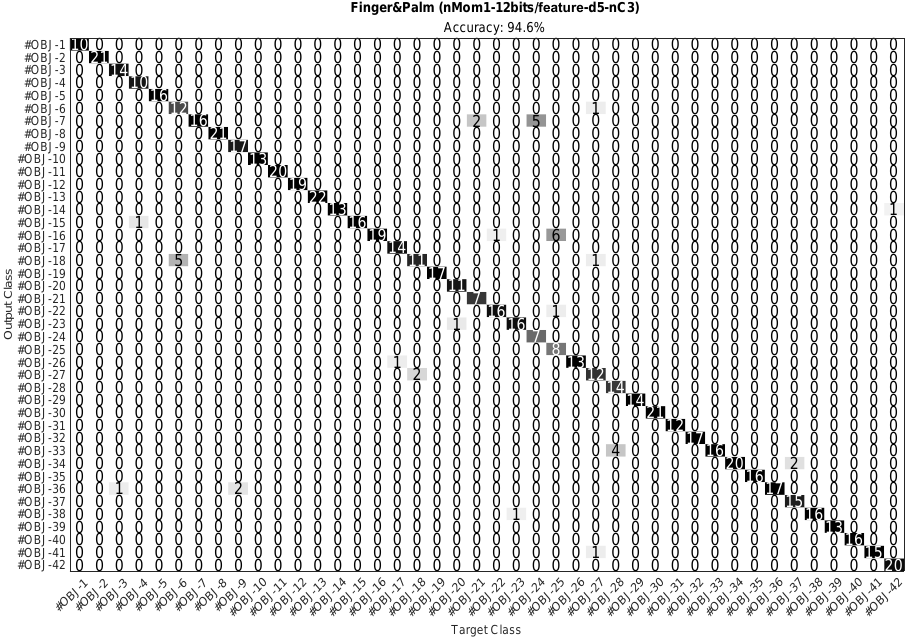
Figure 14. Confusion matrix of the optimal implementation in Figure 13. This case (second row of Table 6, used the first raw moment M 0,0 for both finger and palm, the d5 feature, and 12 bits per feature, and three principal